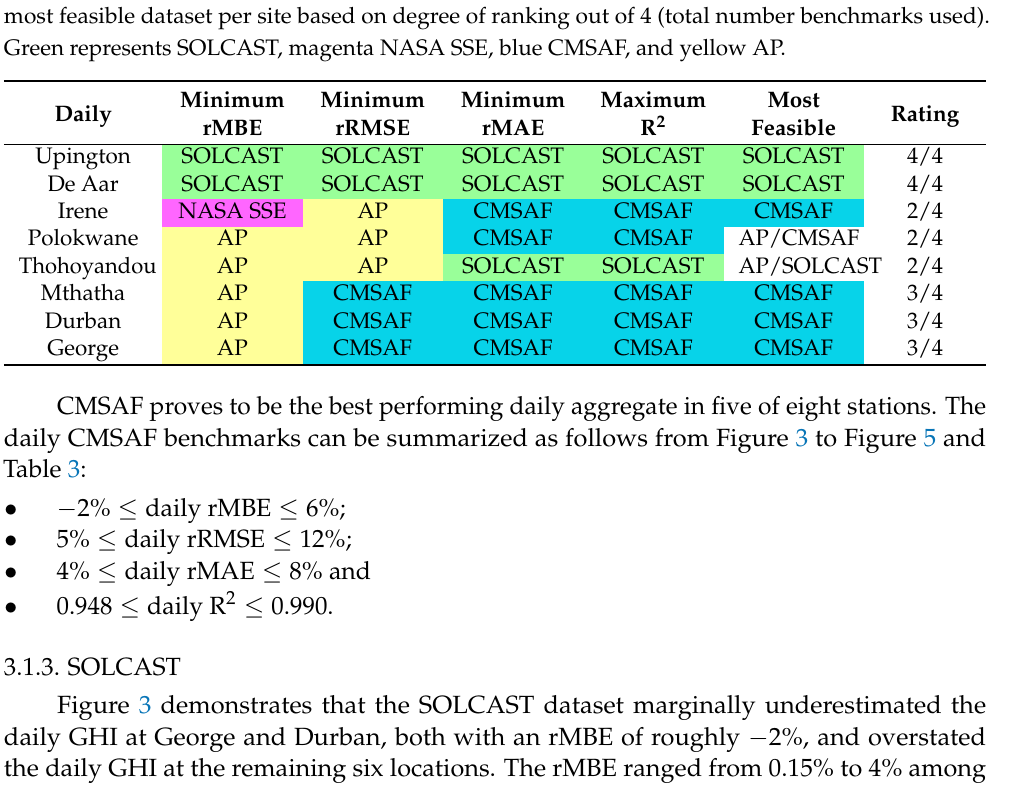
Figure 5. The daily rMAE of the estimated GHI datasets under all-sky conditions. Table 3. The daily average observed GHI (W/m 2 ) and the correlation (R 2 ) between the estimated datasets and the observed GHI in all-sky conditions. Green is the best (R 2 > 0.975), blue is the inter- mediate ( 0.925 ≤ R (cid:2870) ≤ 0.975 ), and yellow is the poor relationship (R (cid:2870) < 0.925) .